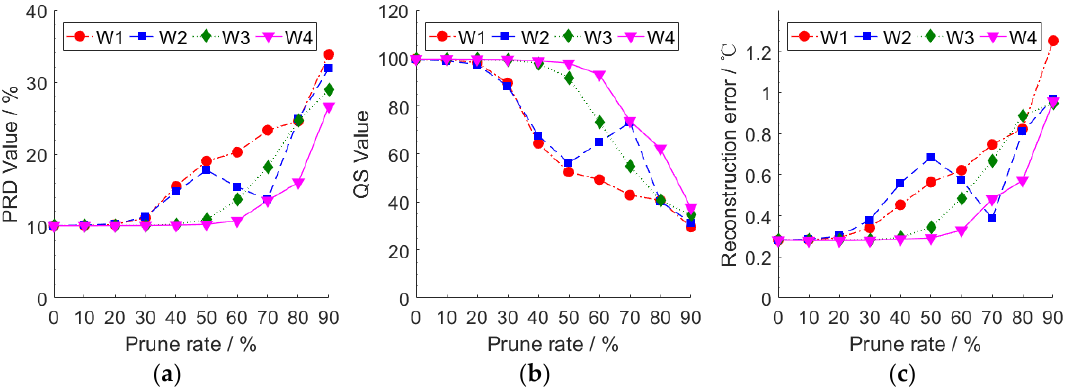
Figure 15. ( a ) The PRD value under different prune rates of each layer; ( b ) the QS value under different prune rates of each layer; ( c ) the reconstruction error under different prune rates of each layer.